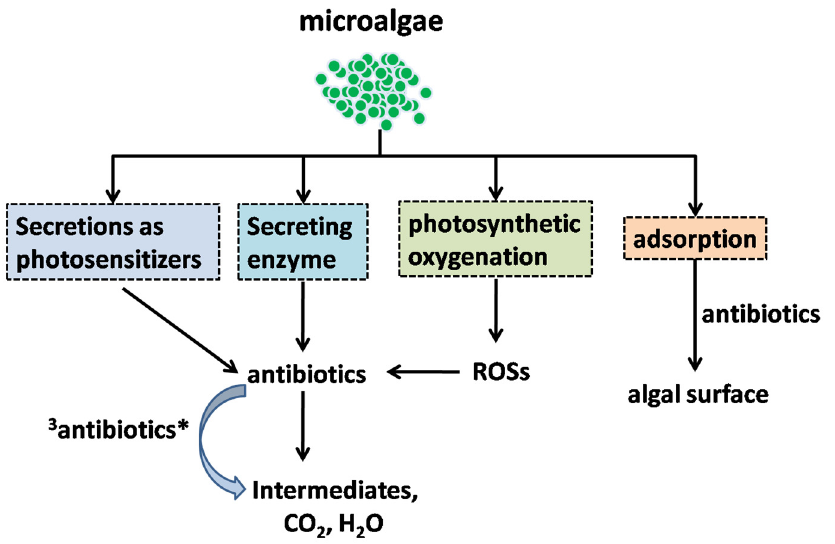
Figure 10. Putative antibiotic removal mechanisms by microalgae ( 3 antibiotics*: triplet excited- state antibiotics). state